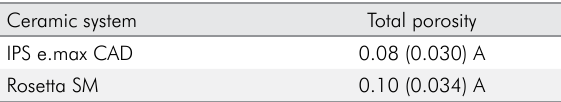
Table 1. Total porosity percentage (SD) for CAD-CAM lithium disilicate glass ceramic systems.